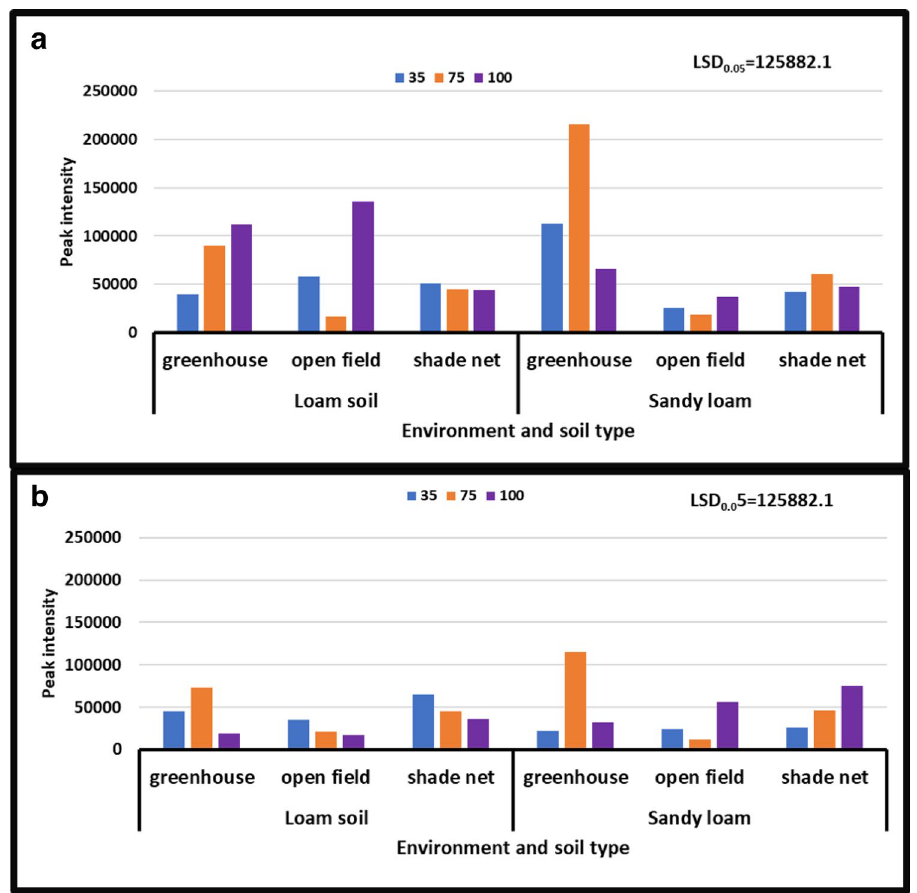
Figure 9. Treatment interaction effect on Niacinamide of African horned cucumber fruit. 35 means severe water stress; 75 means moderate water stress; 100 means no water stress; ( a ) means treatment interaction of irrigation water regimes and soil types at different growing environments during the 2017/18 season; ( b ) means treatment interaction of water stress levels and soil types at different growing environments during the 2018/19 season. Values are average over treatment. Peak intensity showing LCMS-8040 triple quadrupole mass spectrometer intensities which represent the quantity of metabolites varying with treatments. LSD 0.05 is the least significant difference of